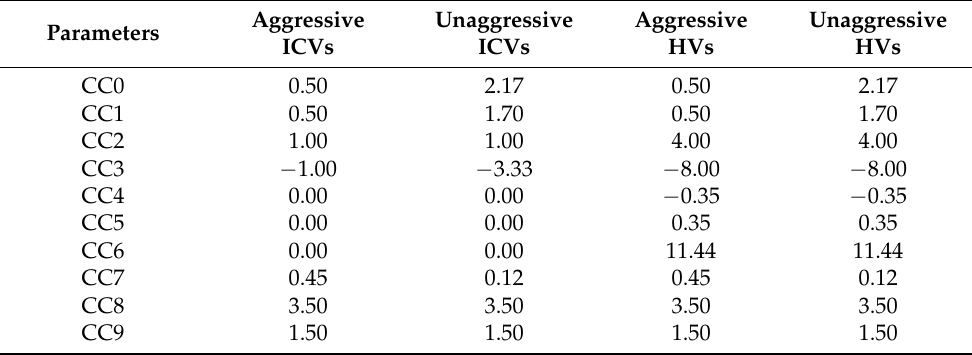
Table 2. Parameter values of the Wiedemann 99 model.